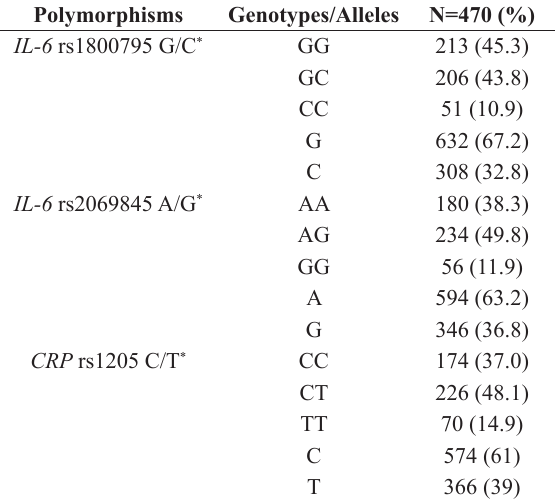
Descriptive allele and genotype